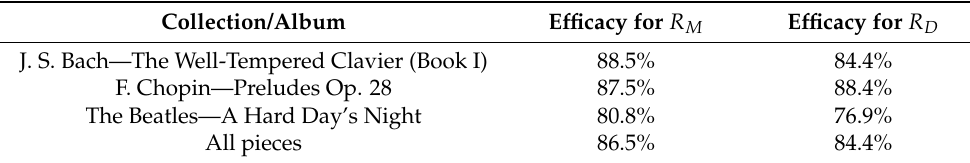
Table 5. Overall * efficacies of the key detection obtained for different weighted pitch-class repre- sentations of analyzed fragments of music using strictly correlational approach based on Albrecht— Shanahan’s profiles (A-S) where R M —the multiplicities of occurrences of individual pitch-classes;